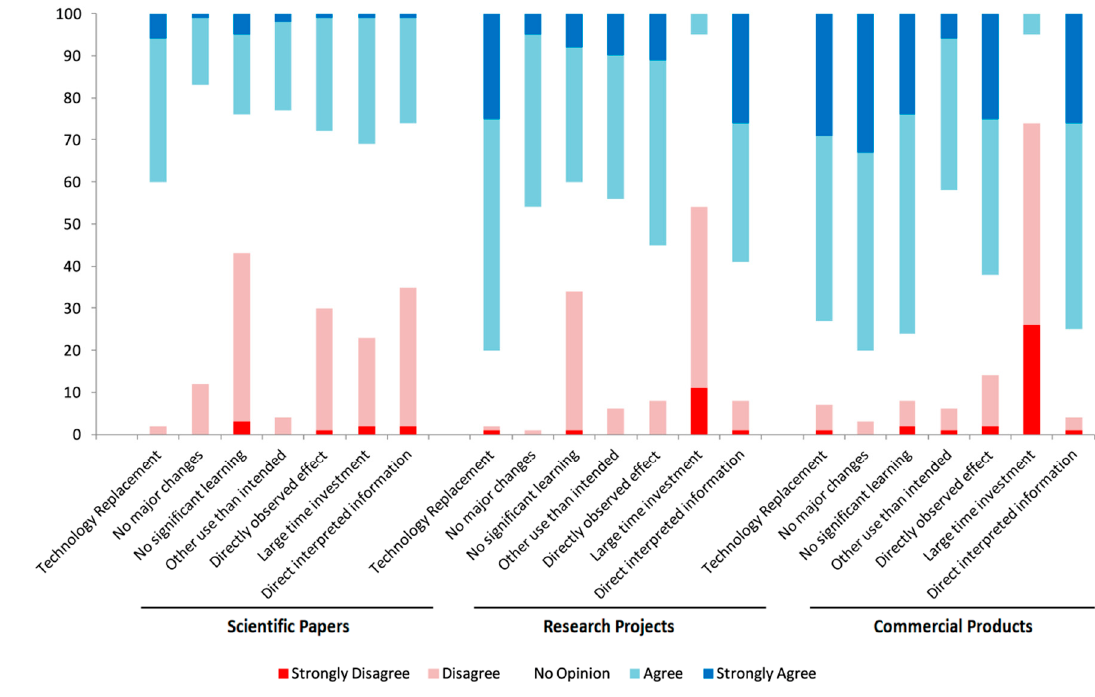
Figure 5. Responses regarding adoption readiness of the smart farming technologies (SFTs) identified in scientific papers, research projects, and commercial products using the Rogers framework [102] based on a Likert scale of five levels (strongly disagree to strongly agree).